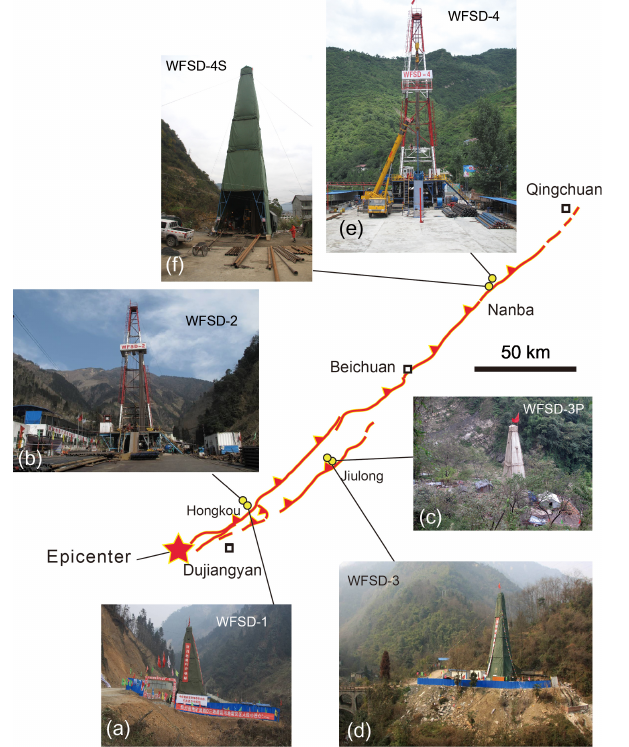
Figure 11. Drilling sites of the Wenchuan Seismic Fault Scientific Drilling along the Longmen Shan thrust